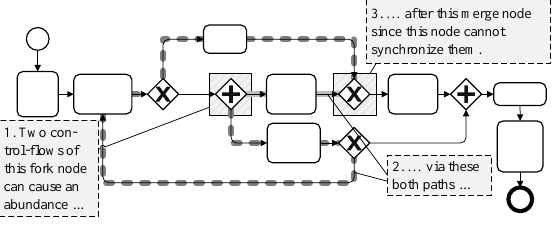
Figure 27. Detailed fault feedback for the potential abundance in the merge node M